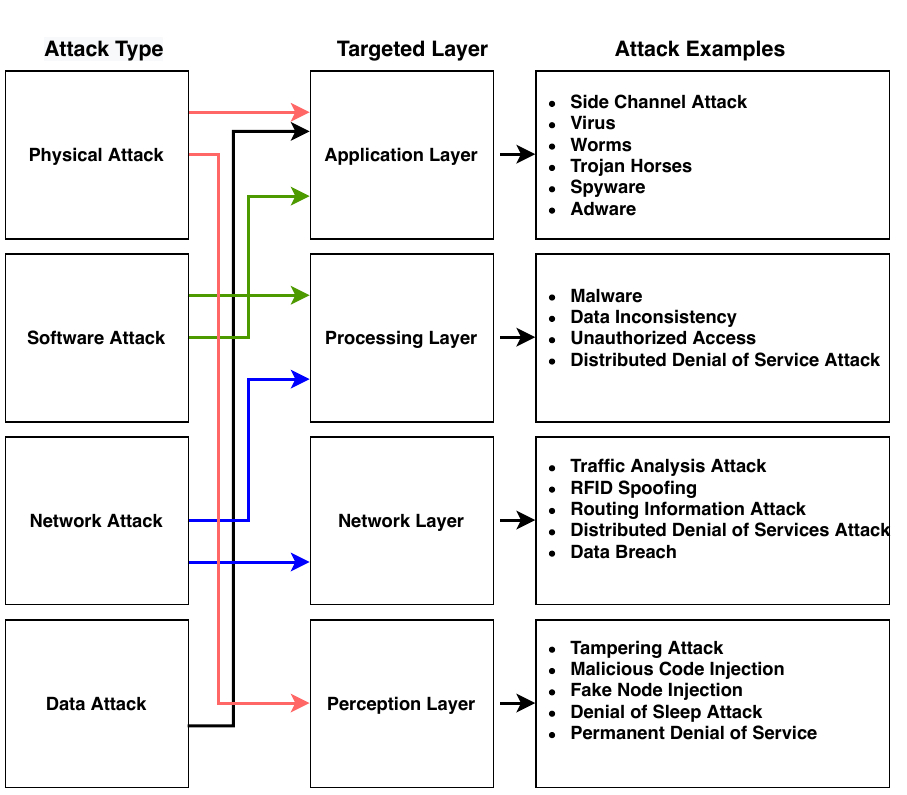
Figure 3. Attacks and Targeted Layers in